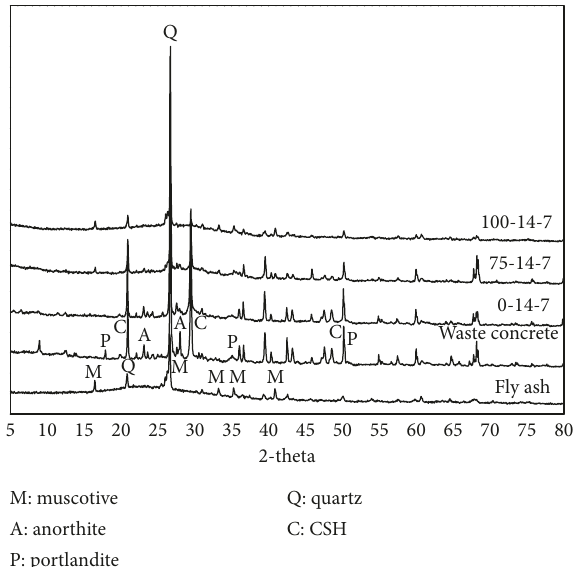
Figure 6: XRD patterns of FA, WC, and the geopolymer specimens produced with, respectively, 0%, 75%, and 100%